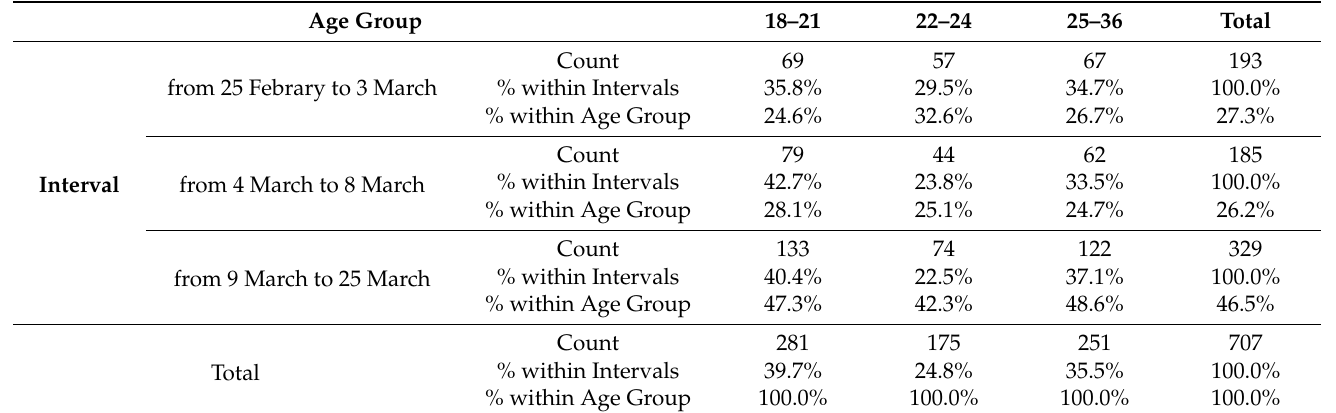
Table 4. Time interval in relation to participants’ age group.